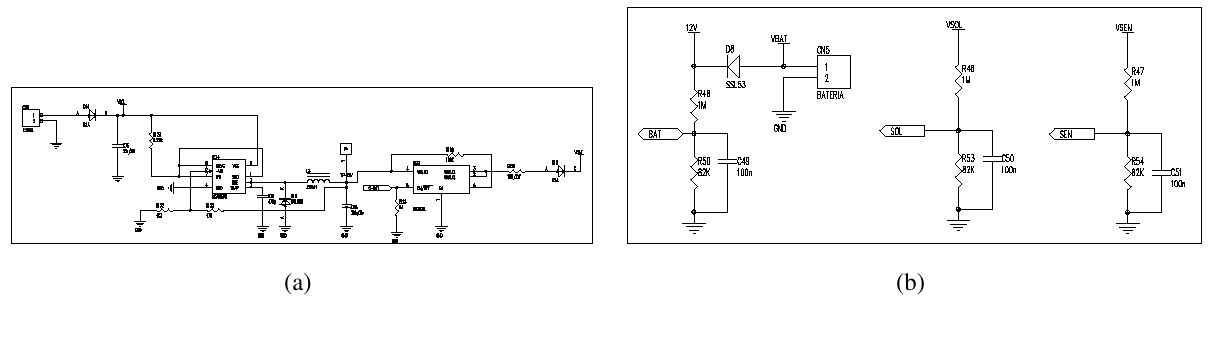
Circuit schematic of the battery, solar-panel, and power-control modules. ( a ) Battery and solar modules, ( b ) secure power control for battery, solar panel, and sensor.